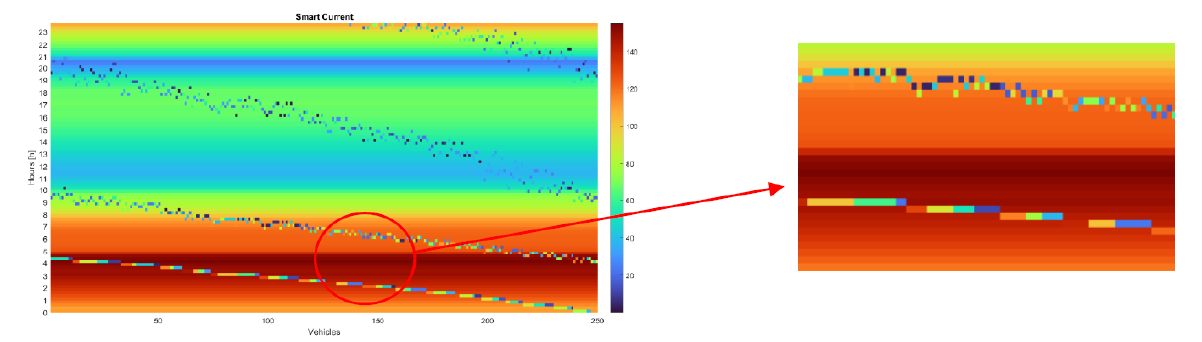
Figure 9. Zoom of the Currents I e for the nearly charged EBs.